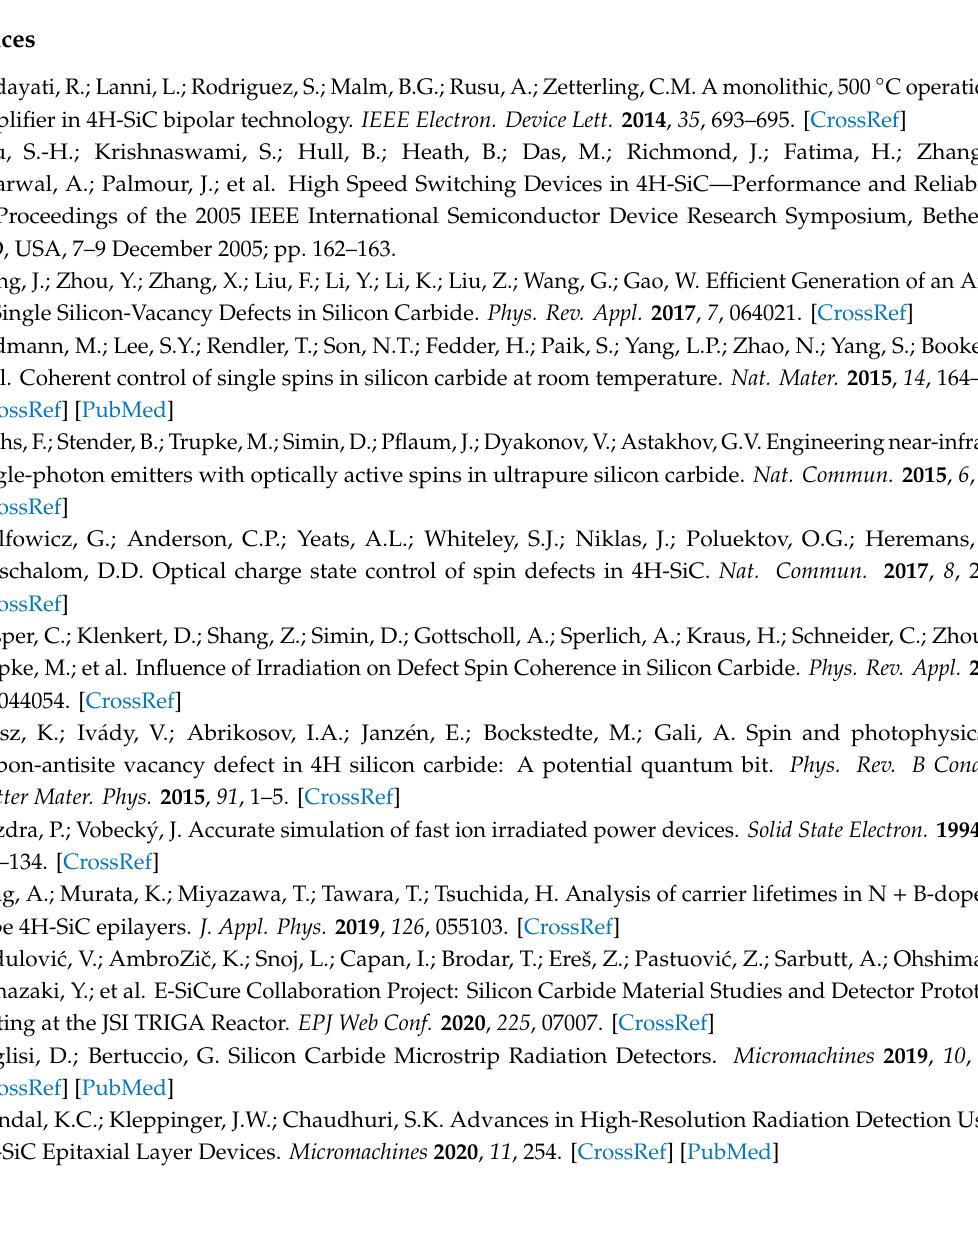
340 K down to 210 K under − 10V bias. Depth profiles measured before 450 K annealing (as seen in Figure 6) are shown with dotted lines. The contribution of an additional deep level defect involving interstitials is labeled as X, Figure S6: Pulse width dependence of EH1 and EH1 + M1 DLTS signal amplitudes in neutron (10 13 cm − 2 ) irradiated SBD. DLTS signal amplitude of M1 deep level is determined by subtracting EH1 + M1 and EH1 DLTS signals. Measurements are carried out at a temperature of 210 K using 50 1 / s emission rate window. Reverse and pulse voltages were − 10 V and − 0.1 V,